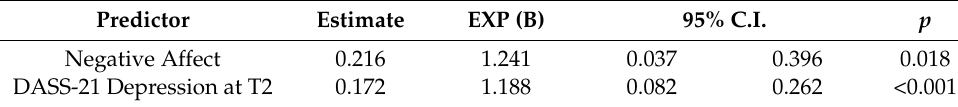
Table 3. The association between significant variables ( n = 173 *) and levels of depression at T3.